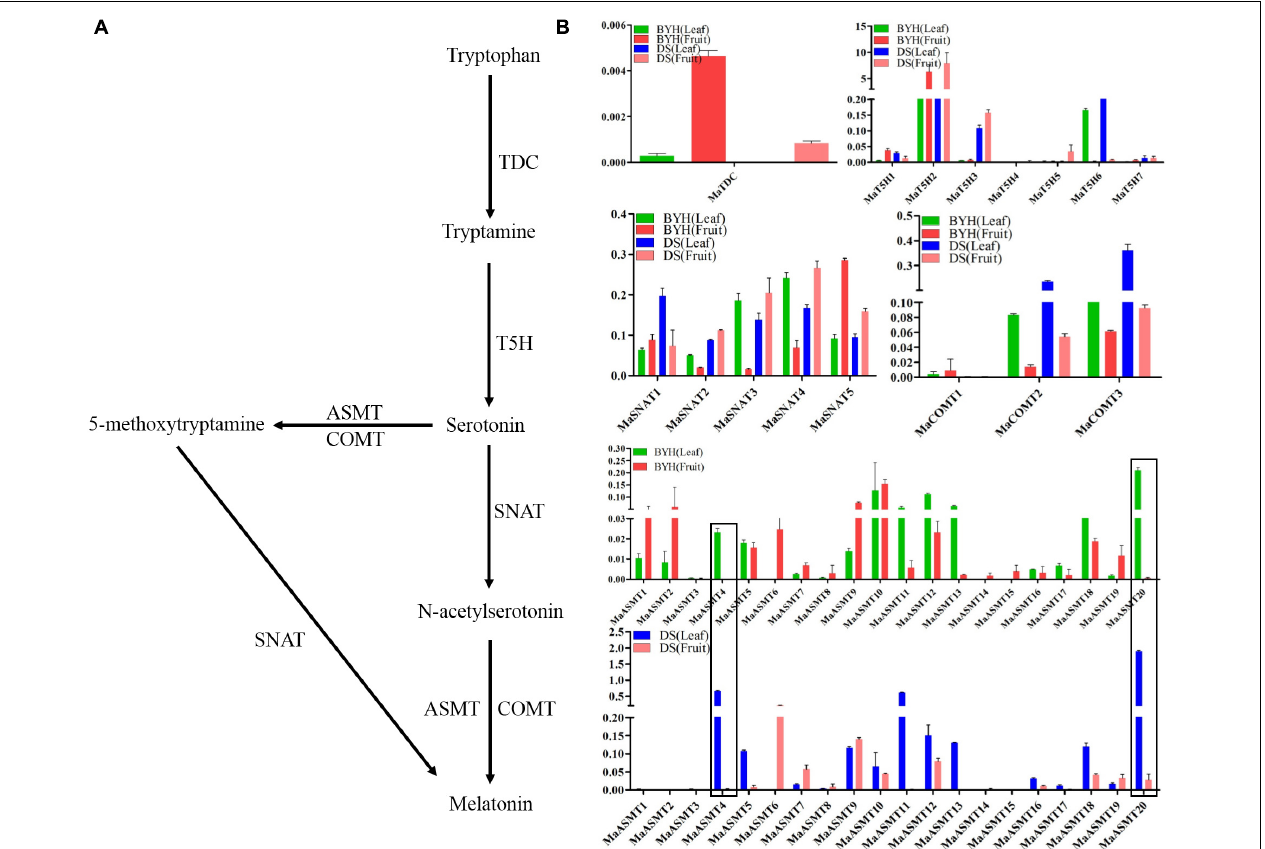
FIGURE 3 | Expressional analysis of genes involved in the biosynthesis of melatonin and its isomers in two tissues (leaf, fruit) of two mulberry varieties sampled in 2017. (A) Biosynthetic pathway of melatonin. (B) The expression profiles of genes involved in the biosynthesis of melatonin and its isomers. BYH represents the “Baiyuhuang” variety; DS represents the “Dashi” variety. Data are means ± SDs ( n =